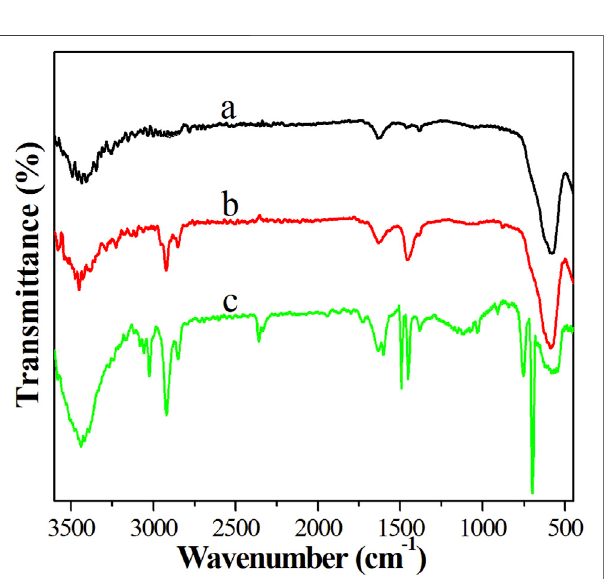
3 O 4 , (B) OA-Fe 3 O 4 , and (C) PS/